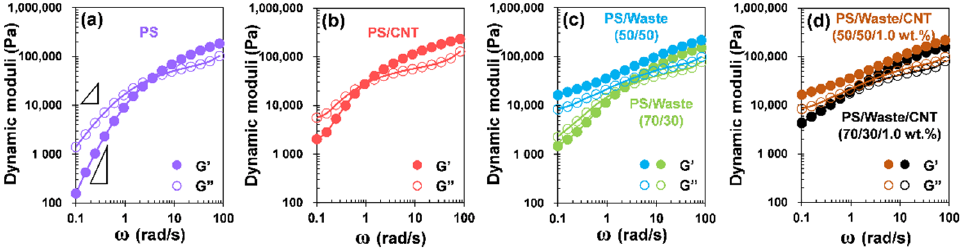
Figure 2. Storage G’ (solid circles) and loss G” (open symbols) moduli of ( a ) PS, ( b ) PS/CNT, ( c ) PS/Waste and ( d ) PS/Waste/CNT as a function of angular frequency at a fixed strain amplitude of 𝛾 (cid:2868) = 1% at 180 °C.